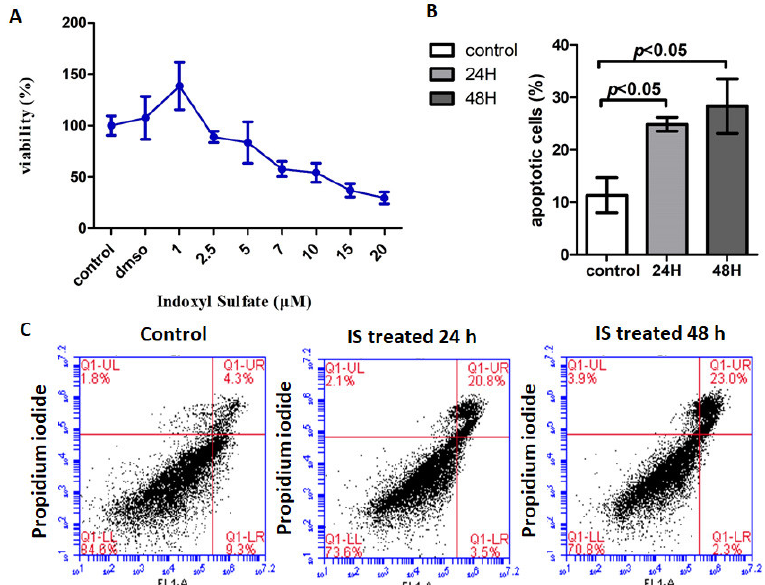
Figure 2. The cellular toxicity of IS treated human astrocyte. ( A ) Effect of IS on cell viability of human astrocytes. Cell viability was assessed with WST-1 assay after 72 h of treatment with different concentrations of IS. The cell toxicity of IS was found to be dose dependent. Exposure to 1, 2.5, 5, 7.5, 10, 15, and 20 µ M IS decreased cell viability. The graph represents mean cell viability (%) ± standard deviation (SD) of three independent experiments. ( B ) IS induced human astrocyte apoptosis at 24 h and 48 h compared to control. ( C ) Human astrocytes were treated in either control or IS for 24 h and 48 h. The results were analyzed using a flow cytometer with